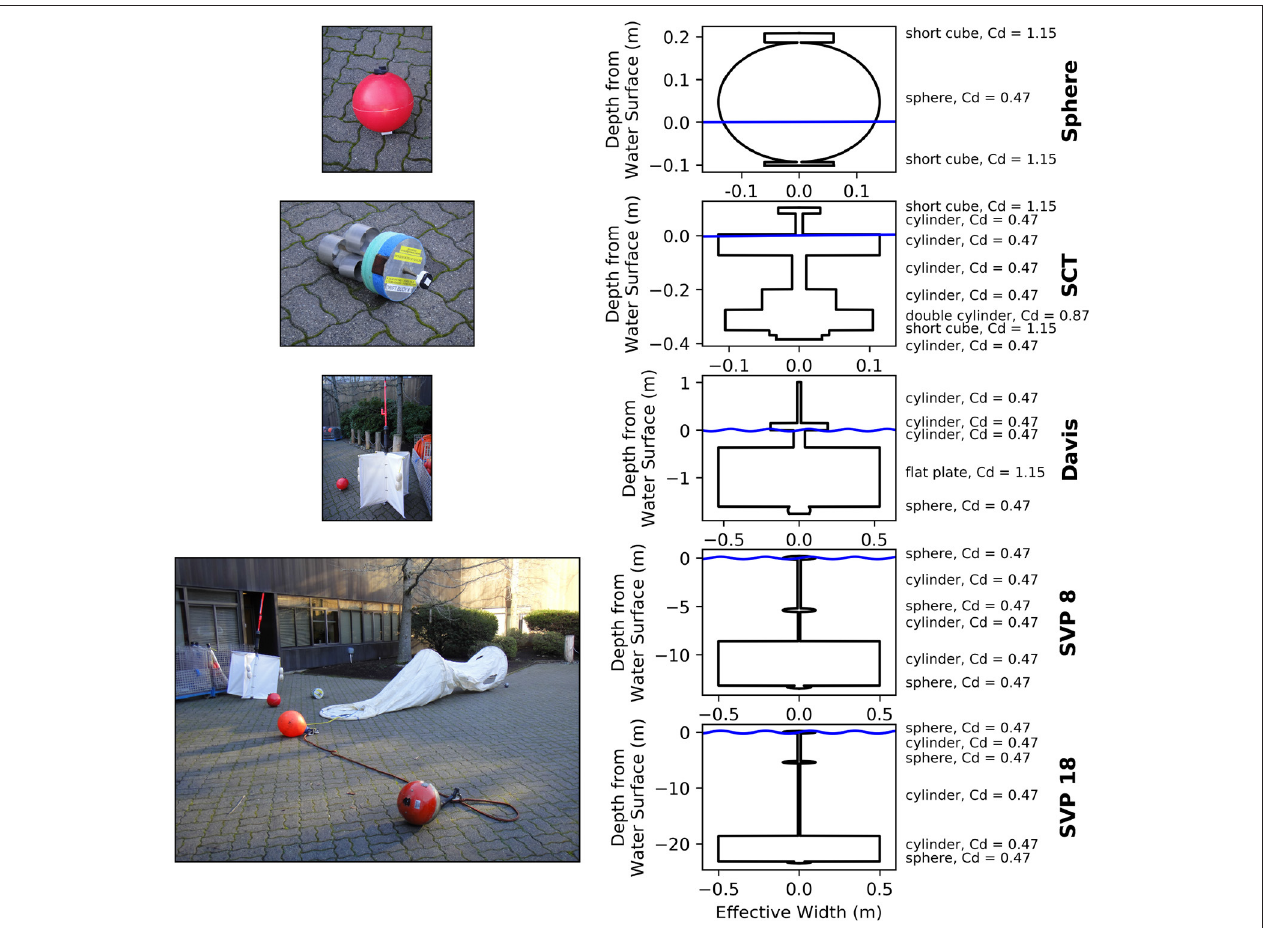
FIGURE 5 | The drifters deployed for this study (left), and their idealized geometry, including approximate drag coefficients (right). The SVP 8 (bottom-left photograph) and SVP 18 drifters (no photograph shown) are identical except for the length of the tether.